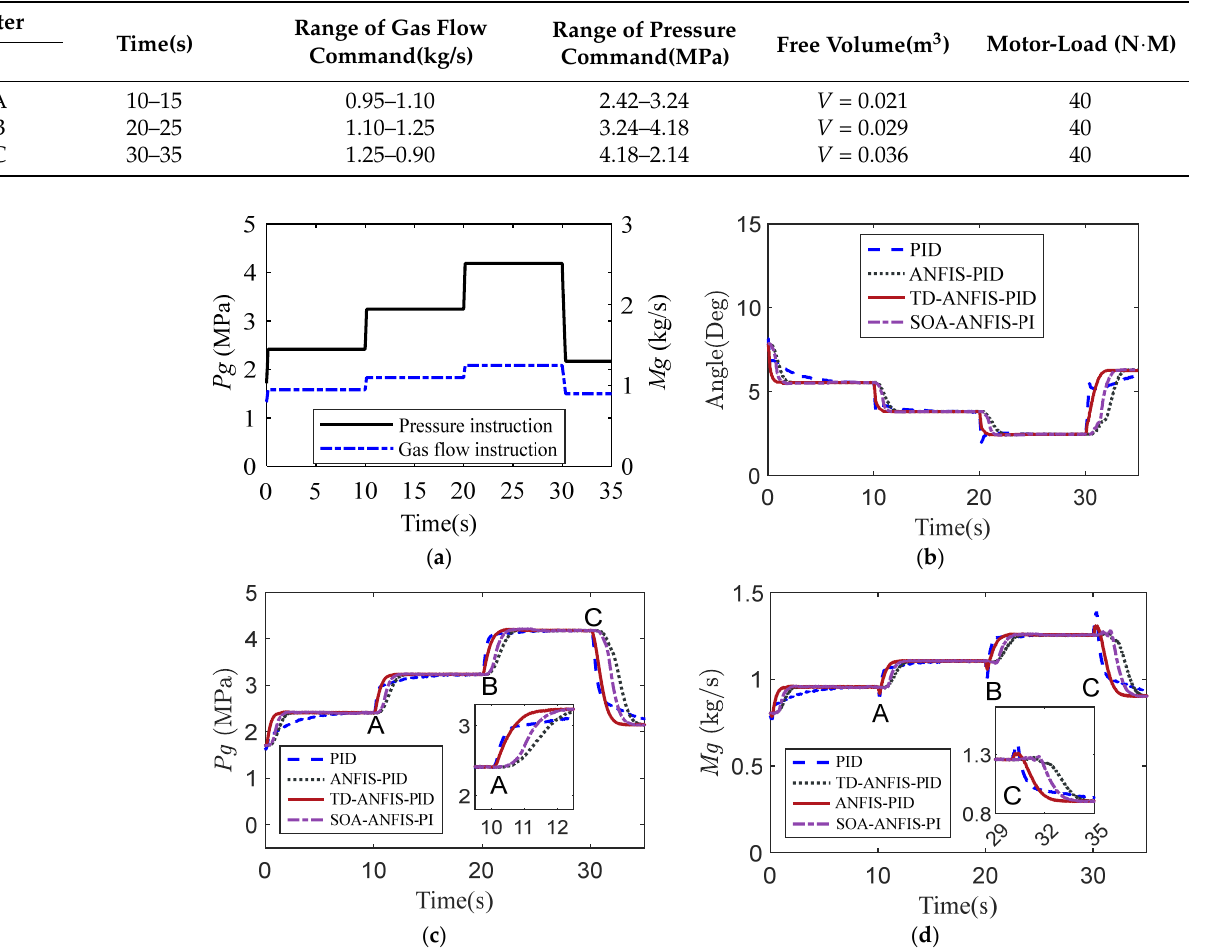
( d ) Pressure response.